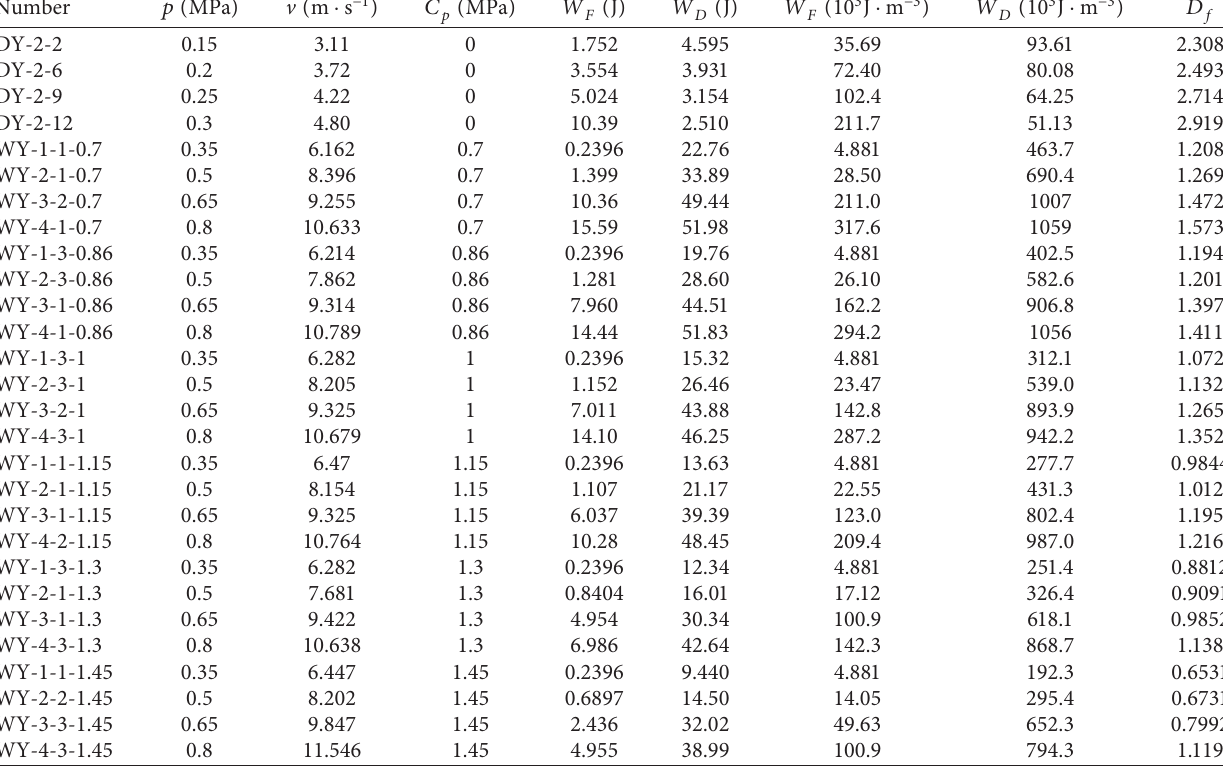
Table 3: Fracture damage energy and fractal dimension of fragmentation degree of specimens.